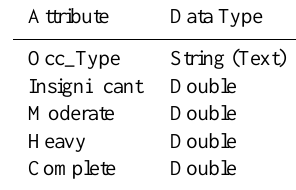
Table 9. Distribution of ignition probability with respect to building damage and PGA